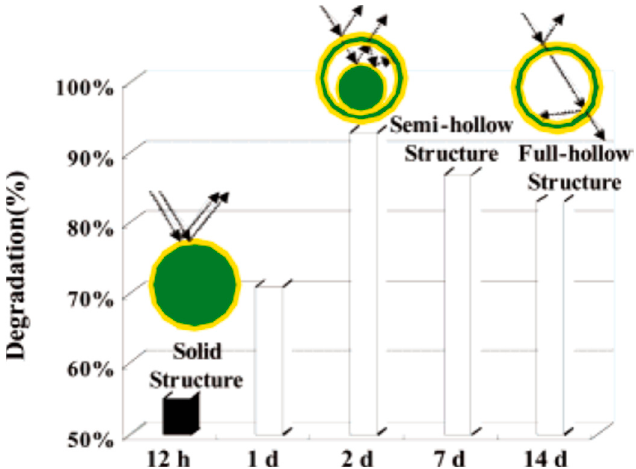
Figure 16. Comparison of photocatalytic activities of titania spheres with solid, sphere-in-sphere, and hollow structures [95]. Copyright 2007 American Chemical